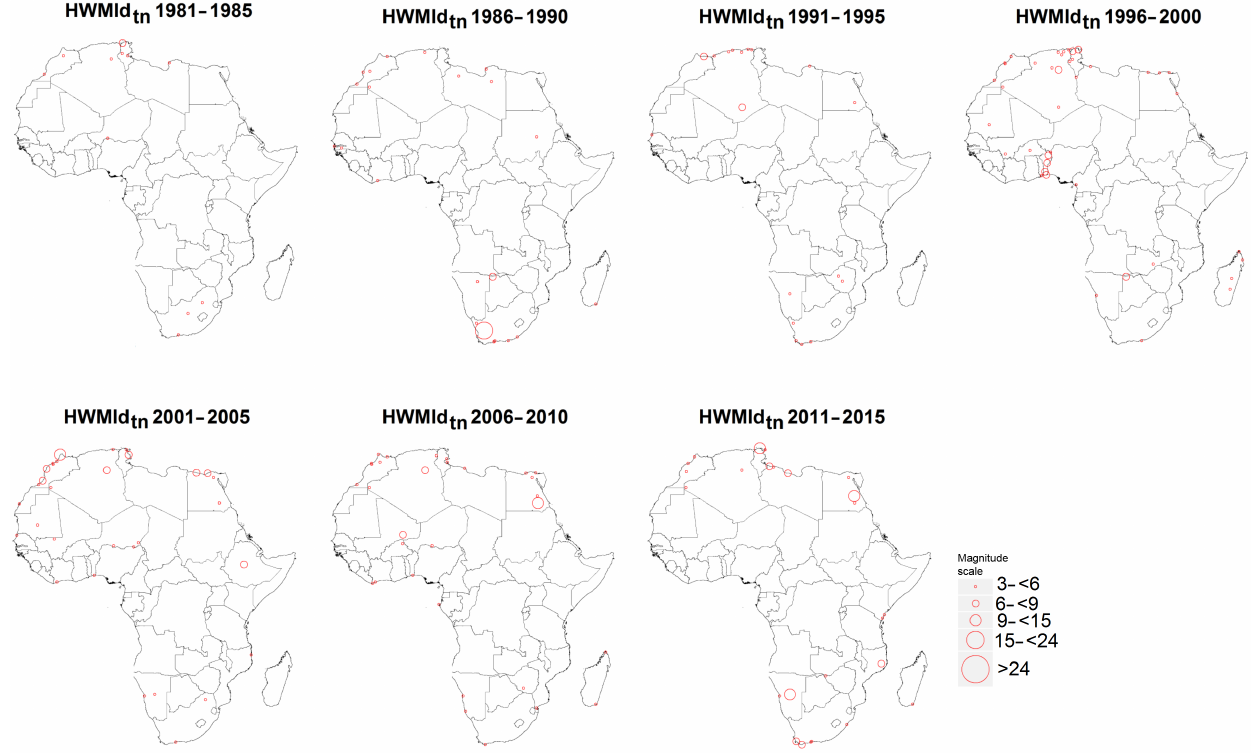
Figure 2. As Fig. 1 but applied to minimum temperature (HWMId tn